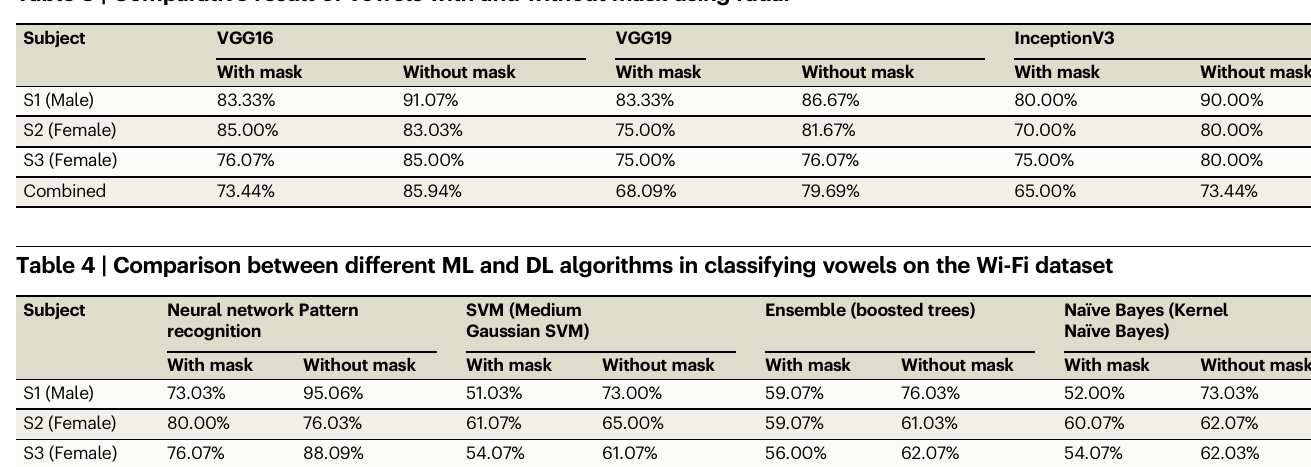
Table 3 | Comparative result of vowels with and without mask using radar